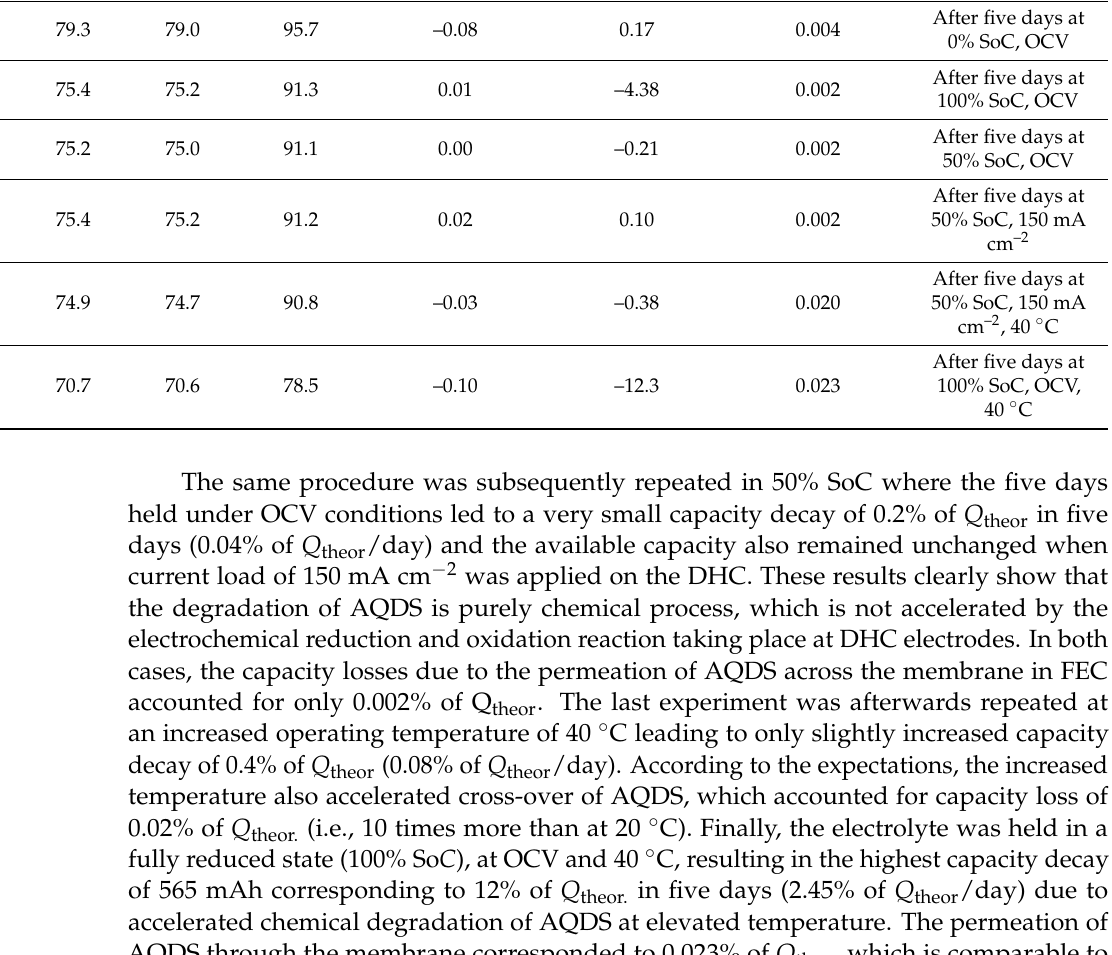
Table 2. Averaged parameters of flow electrolysis working half-cell within whole experiment. Series